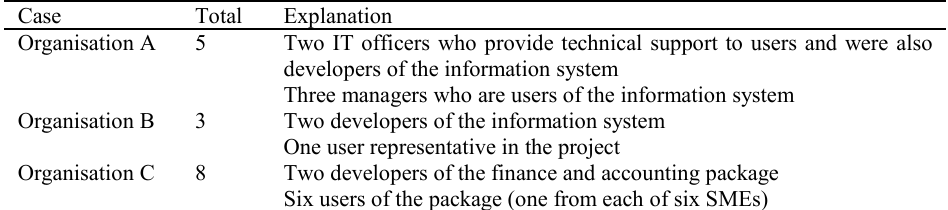
Table 1. Semi-structured interviews with the